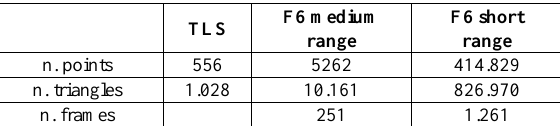
Table 2. Mesh properties of the decorative rosette.